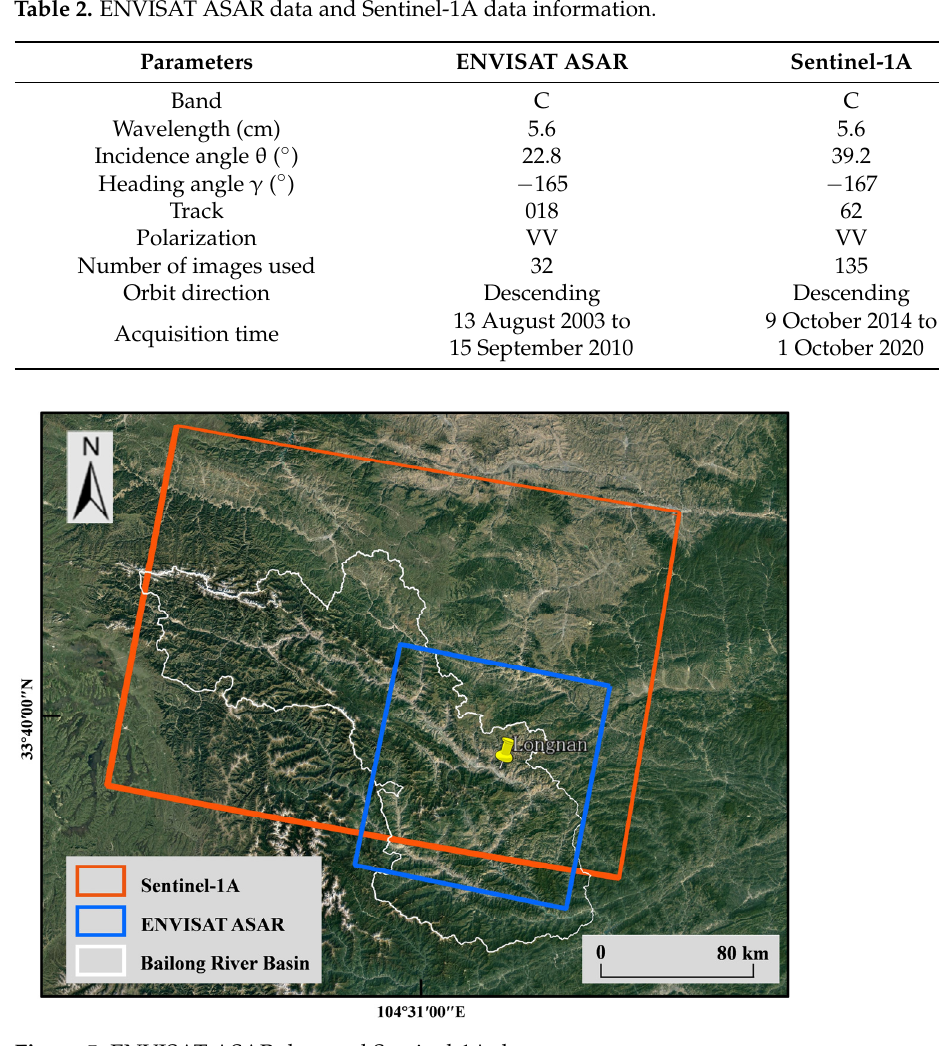
Figure 5. ENVISAT ASAR data and Sentinel-1A data coverage.